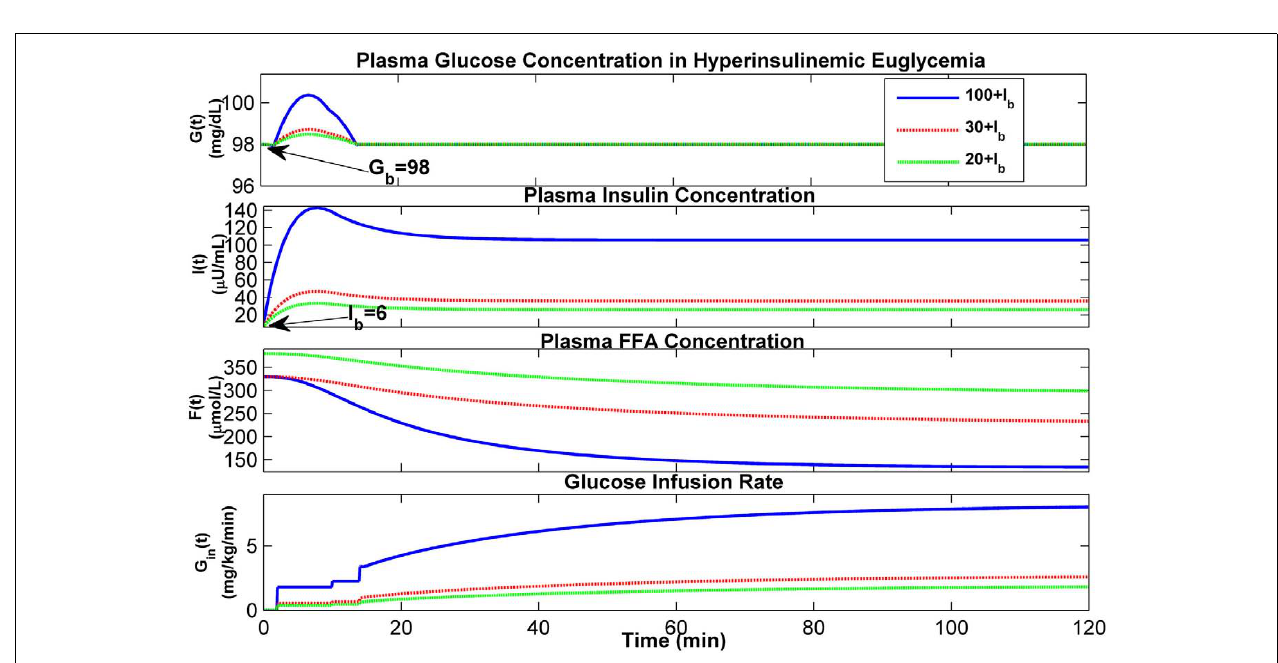
FIGURE 11 | Dynamics of glucose–insulin and FFA during hyperinsulinemic euglycemia with glucose clamps.